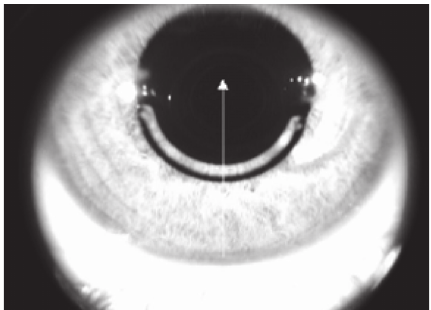
Figure 2: Enface OCT image of the Keraring showing the HD line scan aligned on the segment center and corneal vertex.